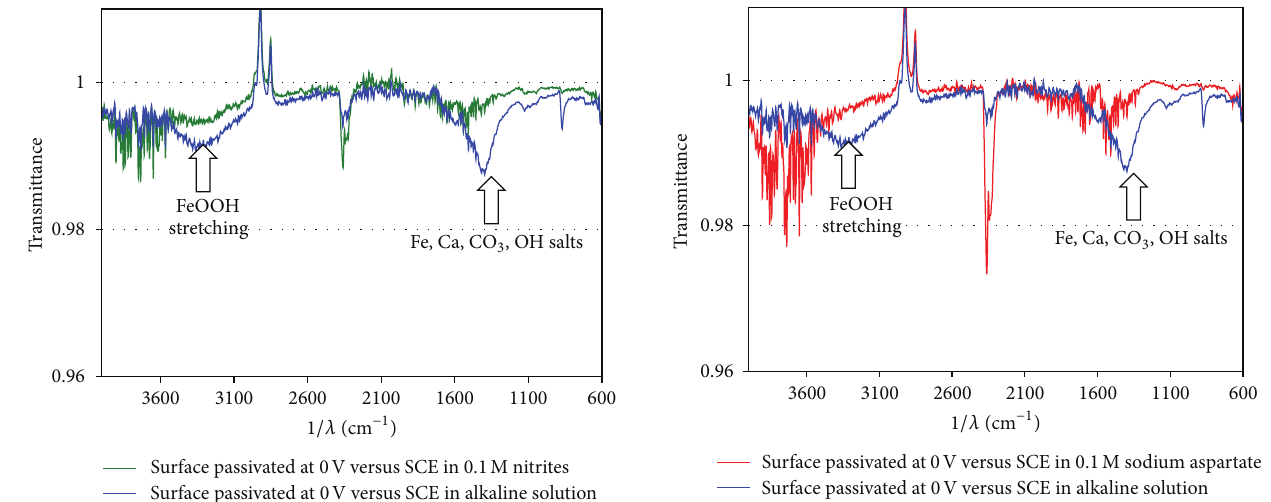
spectrum obtained in absence of inhibitor. After passivation, a clearly visible white scale covers the surface of the